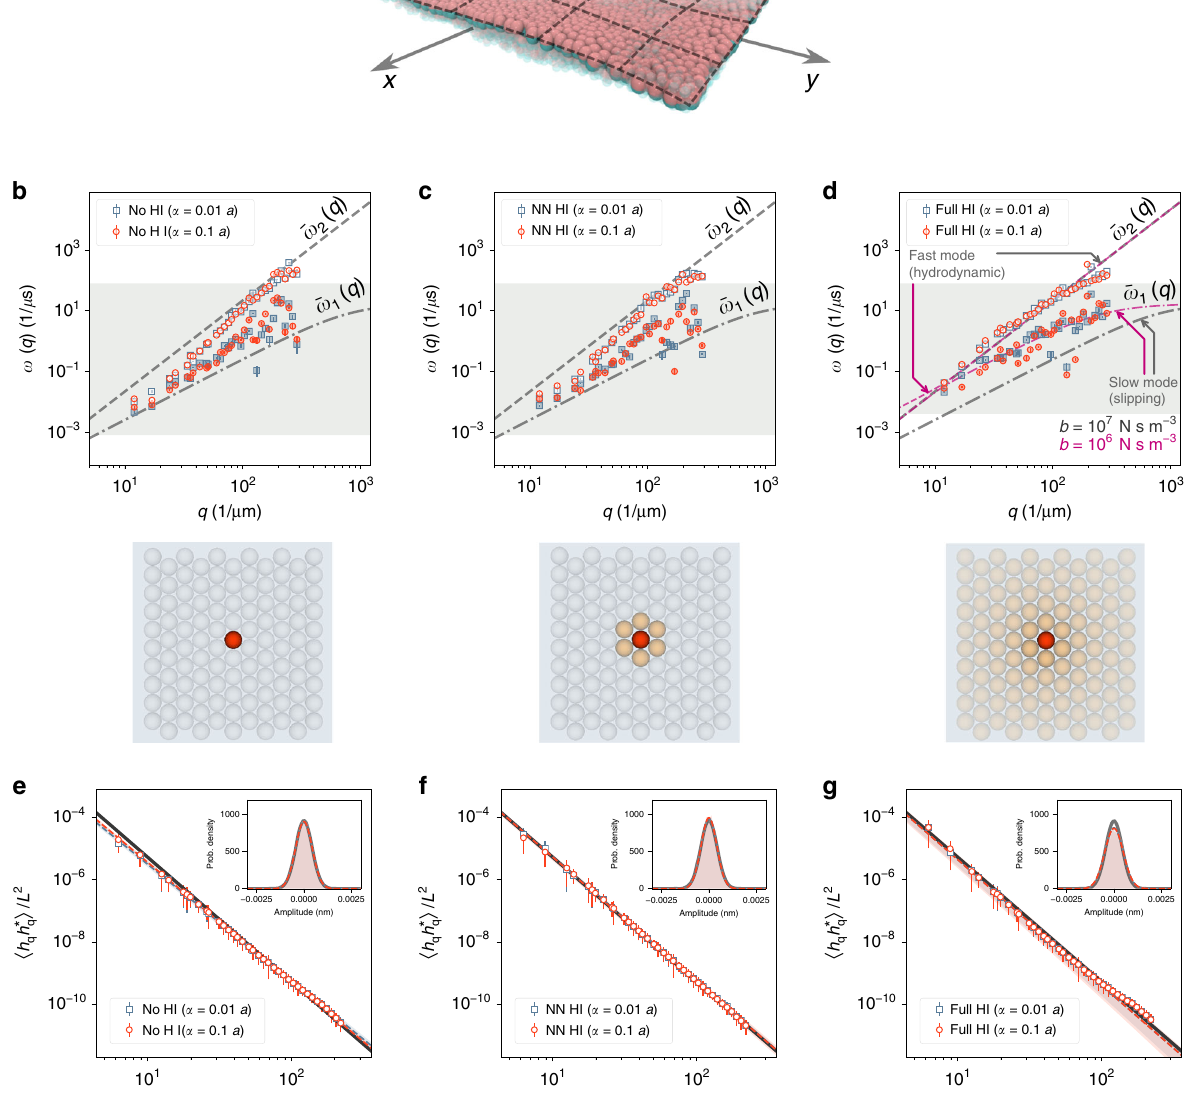
Fig. 3 Simulating equilibrium thermal undulations of a planar membrane suspended in water. a An overlay of several simulation snapshots performed using the mesoscopic membrane model with the lattice parameter of a = 10 nm. Also shown is a schematic depiction of the smooth height function, h x ; y ð Þ fi tted to particle positions in each frame. b – d Dispersion relations for the membrane, calculated based on the assumption that the fl uctuations in the amplitude corresponding to a wave vector q relax biexponentially with frequencies ω 1 ; 2 q ð Þ . The fast regime (higher ω ) is depicted with empty symbols, while fi lled symbols are used for the slow regime. Results are shown for two different choices of the scaling factor α / a . Predictions of the continuum model of Seifert et al. ( (cid:1) ω 1 ; 2 functions from Eqs. (15) and (16)) are included for comparison. In fi gure d , the magenta curves correspond to the same continuum model with a different inter-lea fl et friction coef fi cient (see “ Equilibrium undulations and dispersion relations ” under Methods section). The light grey shaded region signi fi es the range of frequencies available, depending on the sampling rate and the length of the trajectories. The three cases correspond, respectively, to the No HI, NN HI and Full HI hydrodynamic models. e – g Power spectra of thermal undulations of the membrane patches in the aforementioned simulations. Dashed lines are fi ts of the function C qL ð Þ n to the data, whereas the solid black line is the prediction of the continuum model given by Eq. (13). Shaded areas denote 99% prediction intervals of the power-law fi ts. The inset panes are plots of the probability distribution of the real and imaginary parts of h q , binned together, for the short-wavelength mode q ¼ 2 π L 50 ; 50 ð Þ . This mode mostly corresponds to the out-of-plane motion of individual particles and is thus the fastest dynamical mode of the system. The grey curve is the Gaussian distribution predicted by the Helfrich model (see “ Equilibrium undulations and dispersion relations ” under Methods section). Error bars in all plots represent standard